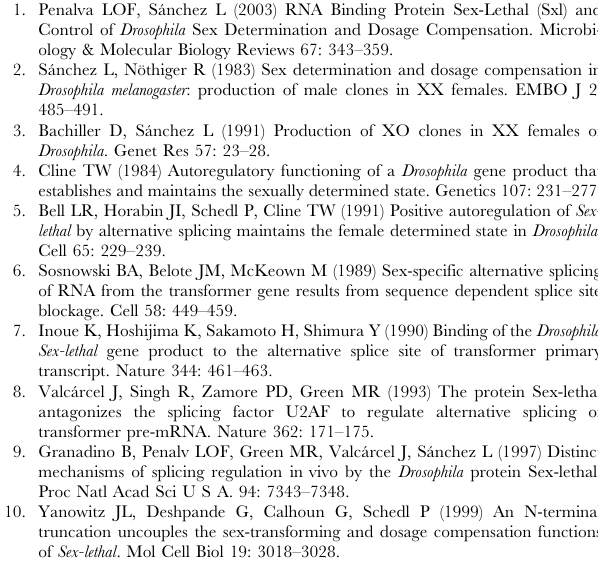
Figure S3 Western-blot hybridised with serum against the Sciara SXL protein [36] showing the expression of the transgenic SXL proteins. The antibody does not recognise Drosophila SXL protein [36]. See text for details. Figure S4 Scheme showing the Drosophila-Sciara chimeric SXL proteins, where the location of the primers used for their construction is indicated. The sequences of the primers and the added sequences for the restriction enzymes are described in Materials and Methods. N-mel, RBD-mel and C-mel stand, respectively, for the amino-terminal domain, the two RNA- binding domains and the carboxyl-terminal domain of Drosophila SXL. N-sci, RBD-sci and C-sci stand, respectively, for the amino- terminal domain, the two RNA-binding domains and the carboxyl-terminal domain of Sciara